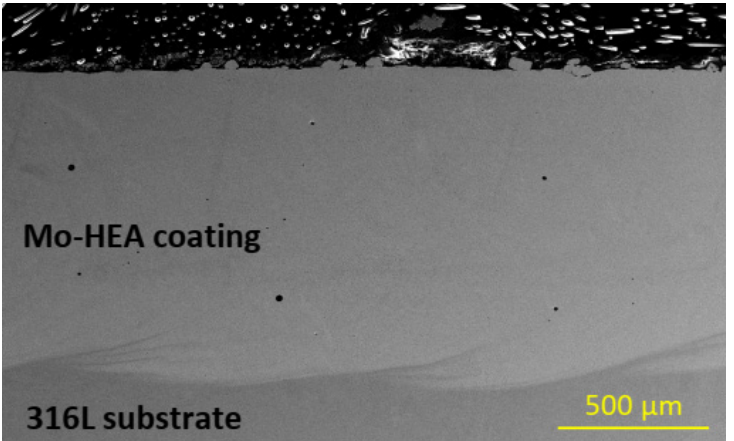
Figure 17. No cracking or erosion damage was observed in the Mo-HEA-316L sample in the erosion testing.